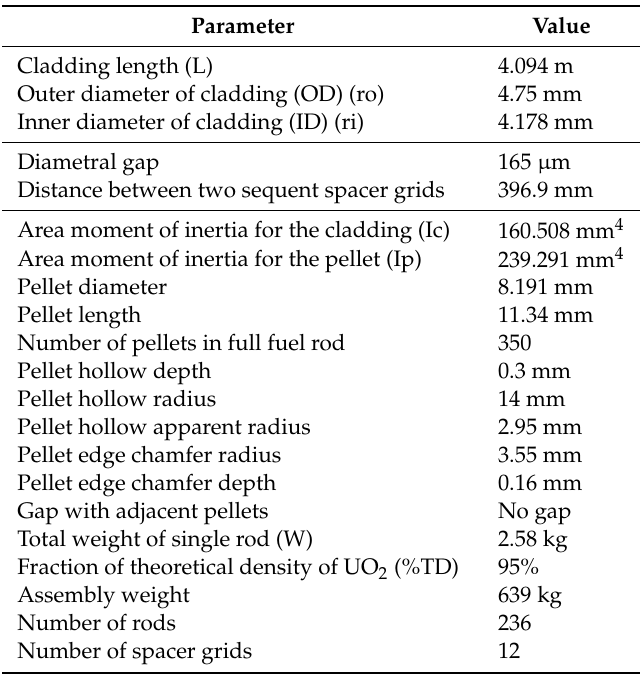
Table 1. Specifications of the fuel rod and assembly